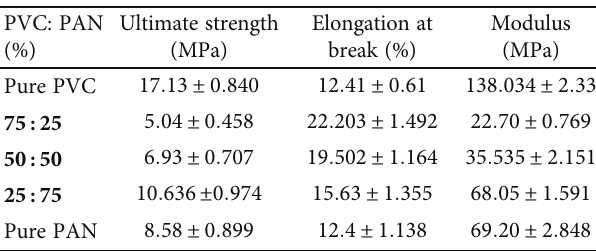
Table 4: Tensile test results for the nonwoven blend mats of PVC: PAN with many blending ratios ( n = 3